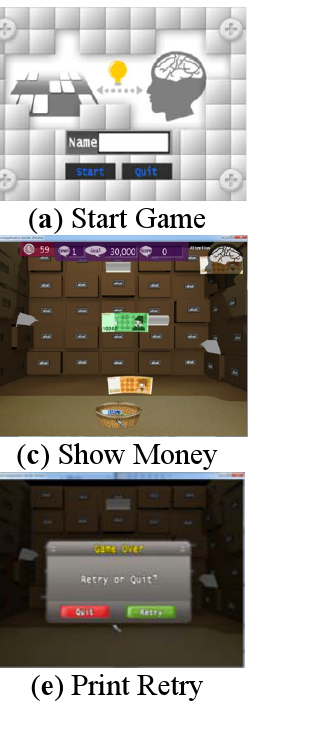
Figure 12. Money game play screen. Game is played according to the flowchart defined by experts and game